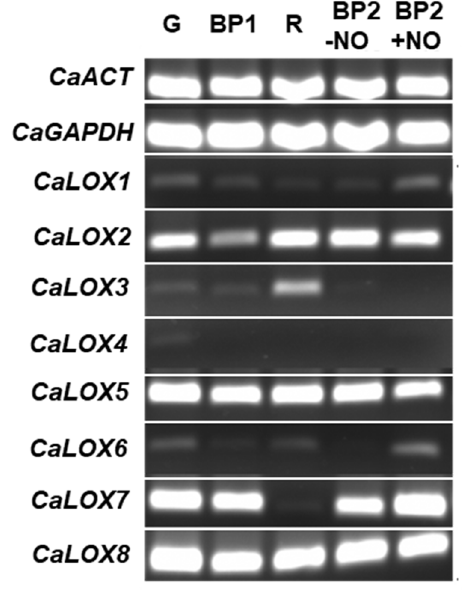
Figure 4. Relative expression of the CaLOX genes (SQ–PCR) in samples of sweet pepper fruits at different ripening stages and under NO treatment. Samples correspond to immature green (G), breaking point 1 (BP1), ripe red (R), and breaking point 2 with and without NO treatment (BP2 + NO and BP2 − NO, respectively). Supplementary Figure S1 illustrates a representative photograph of the experimental design used to analyze the pepper fruit ripening and exposed to NO treatment [23]. ACT, actin. GAPDH, glyceraldehyde ‐ 3 ‐ phosphate dehydrogenase. LOX, lipoxygenase.